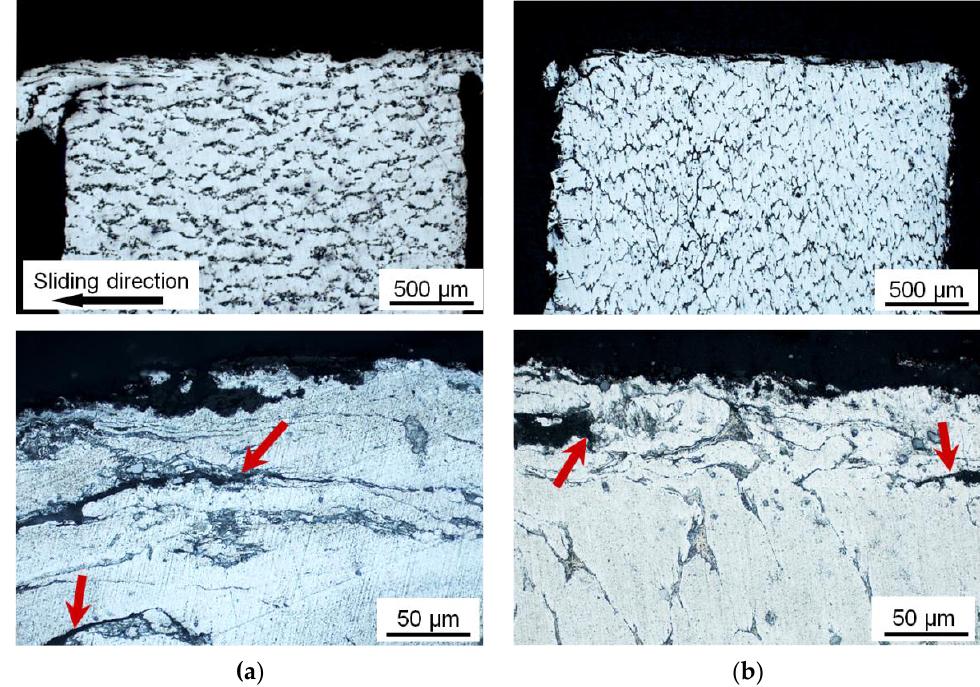
Figure 8. Structure of the subsurface layer of the sintered Al-30Sn alloy after dry friction against steel. Number of ECAP-A passes: ( a ) 0 (sintered); ( b ) 2. P = 5 MPa. Locations of crack propagation are shown by